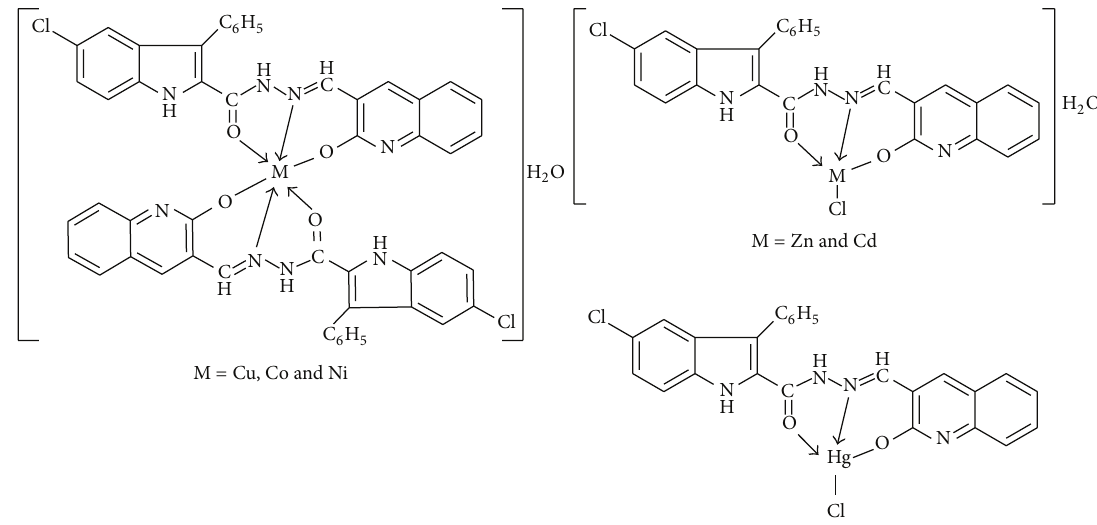
Figure 7: Proposed structures of metal